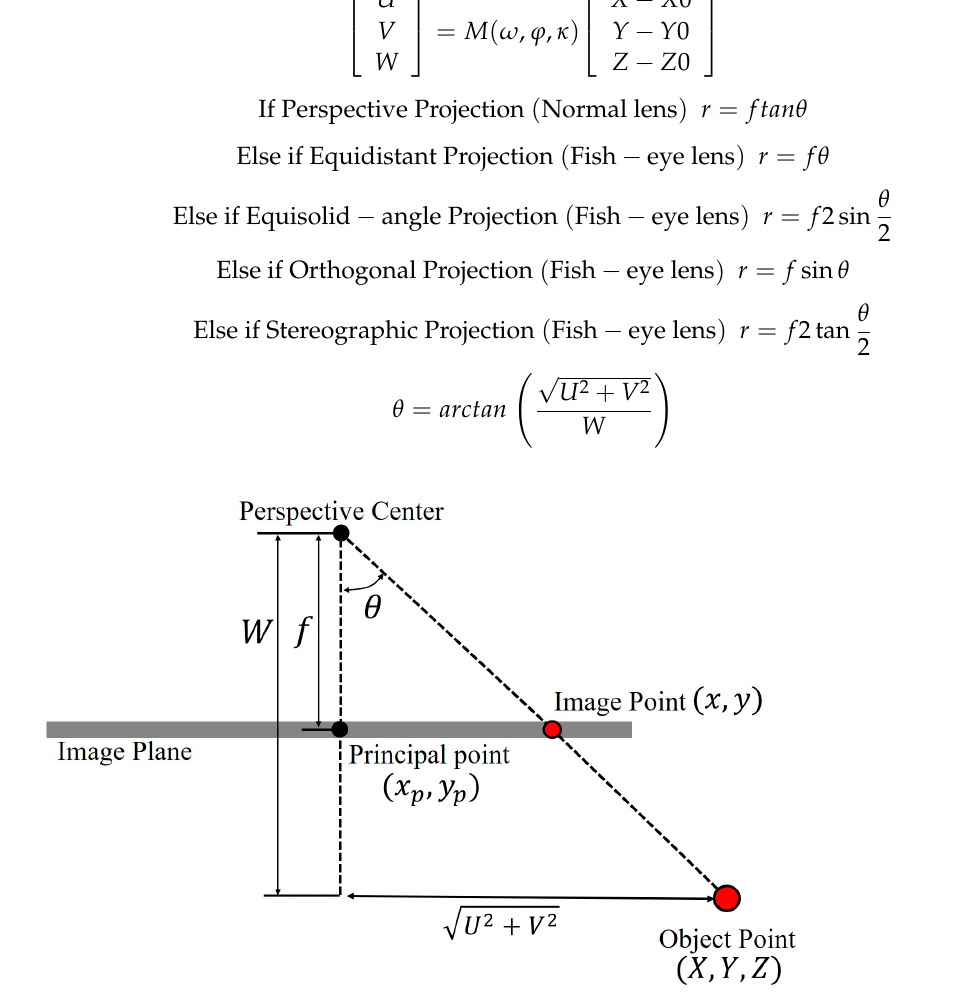
Figure 1. Involved parameters in imaging geometry.